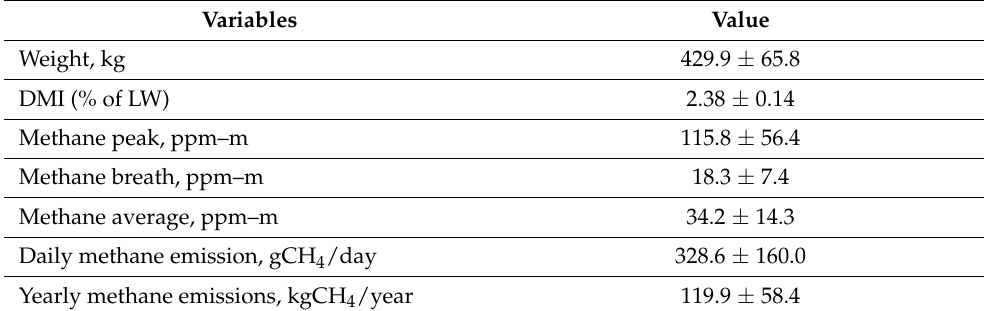
Table 2. Overall average values recorded during the trial, expressed as mean ± s.d.